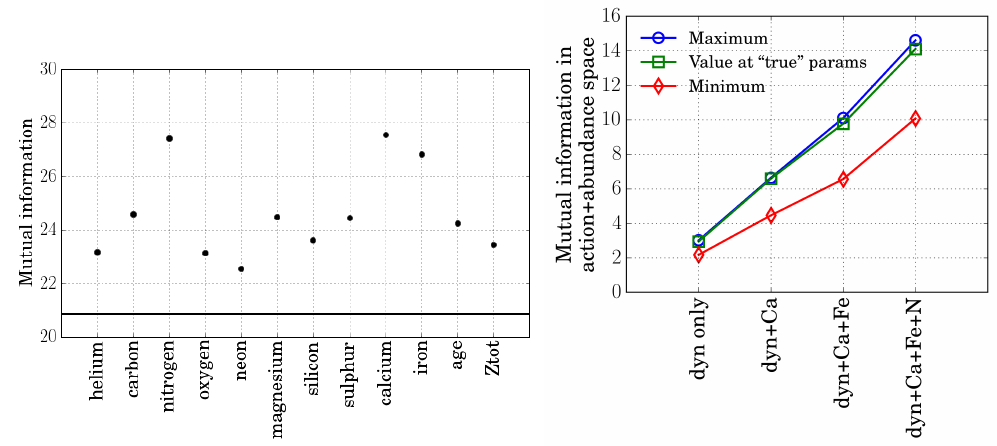
Figure 4. Left : Mutual information of stars in the Latte halo sample, in the space of constants of motion plus one additional label as shown on the horizontal axis. The solid black line shows the value of the mutual information (MI) calculated for constants of motion alone. The elements nitrogen, calcium, and iron appear to be most strongly correlated with the orbits of stars in the tidal streams. Right : MI values at the best-fit (blue), direct-fit (green), and far from the best fit (red) parameters for the gravitational potential, for the Latte stellar halo sample. When additional abundances (Ca, Fe, N) are included as extra dimensions, the contrast between the peak and the background increases relative to the fit when only actions are used (“dyn